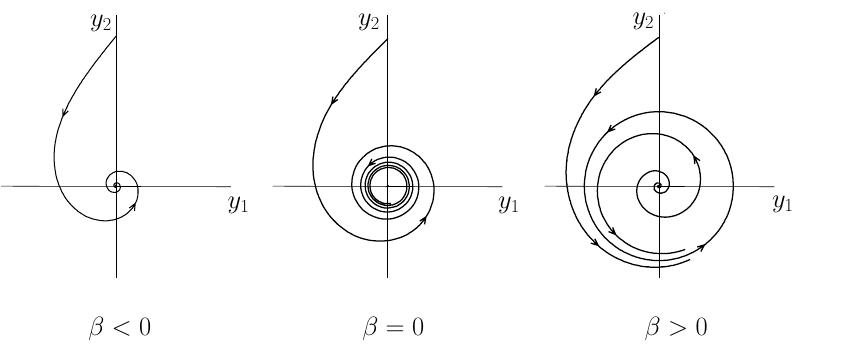
Figure 27. Supercritical Andronov-Hopf bifurcation in the system _ y